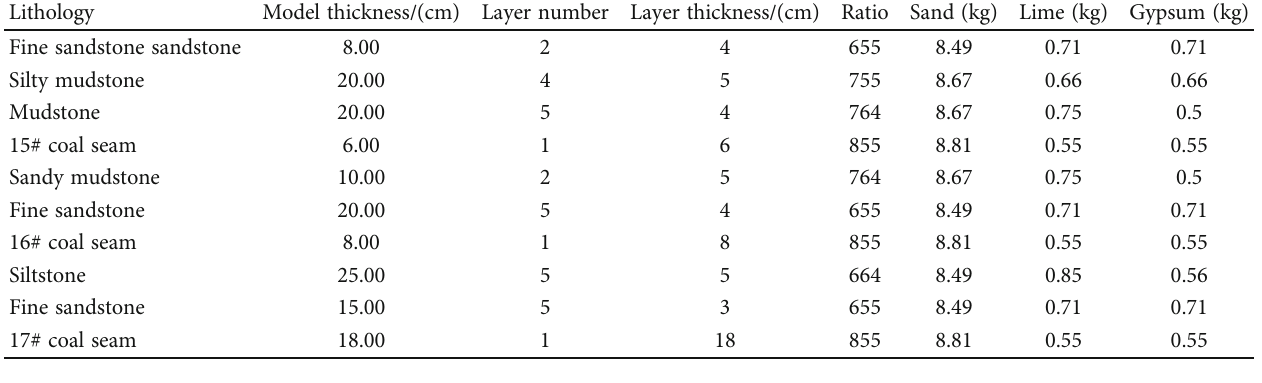
Table 2: Model of similar material ratio of rock strata.